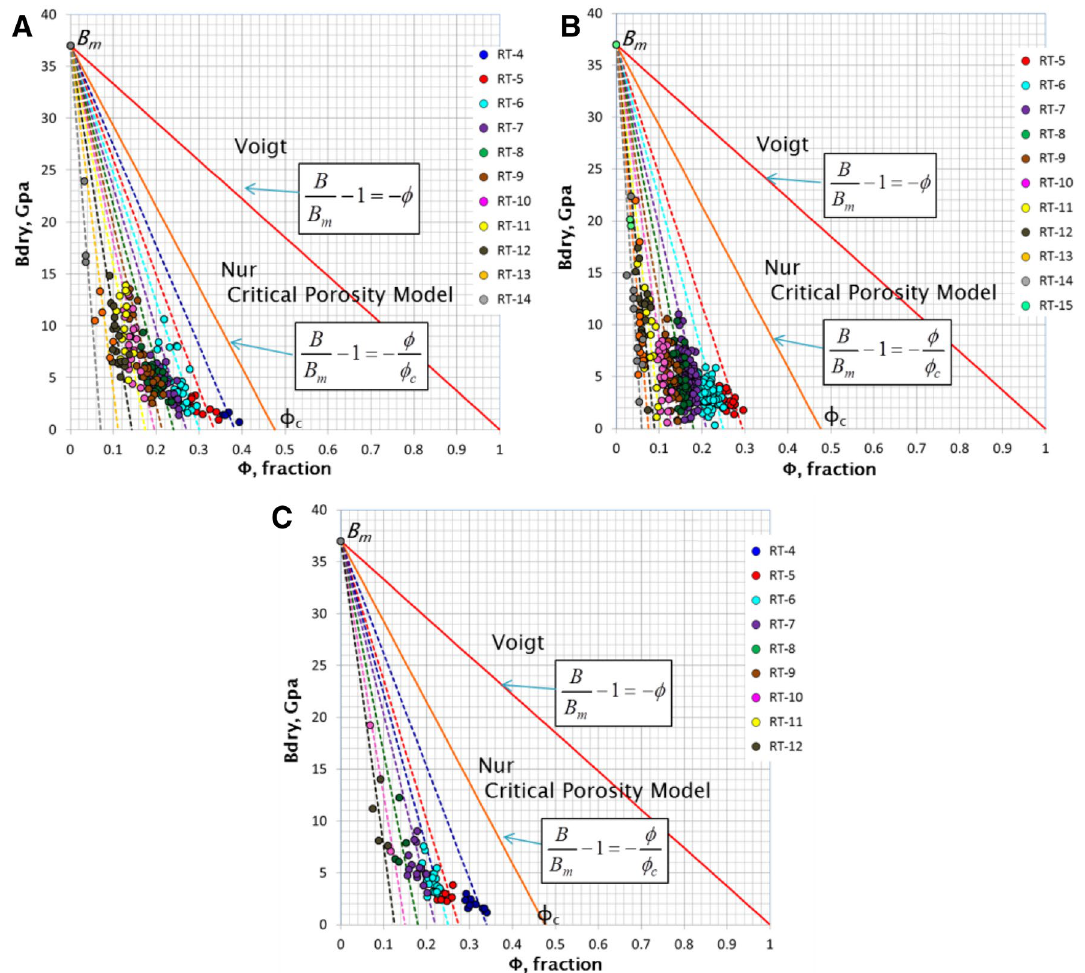
Fig. 2 Plot B dry versus porosity for each rock type compared with Voigt model for data set 1 ( a ), 2 ( b ) and 3 ( c ) (colored dashed line is best fit Nur critical model for each rock type)